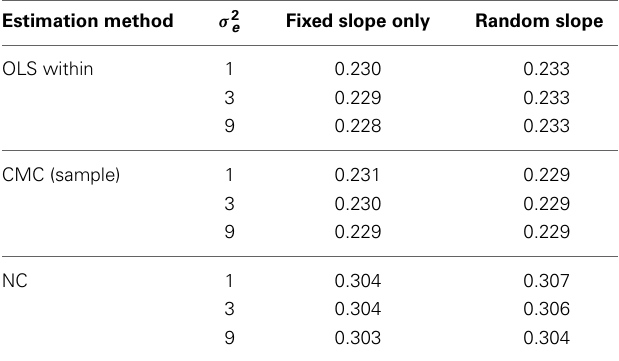
Table 3 | Estimates for fixed effect autoregressive parameter φ . Estimation